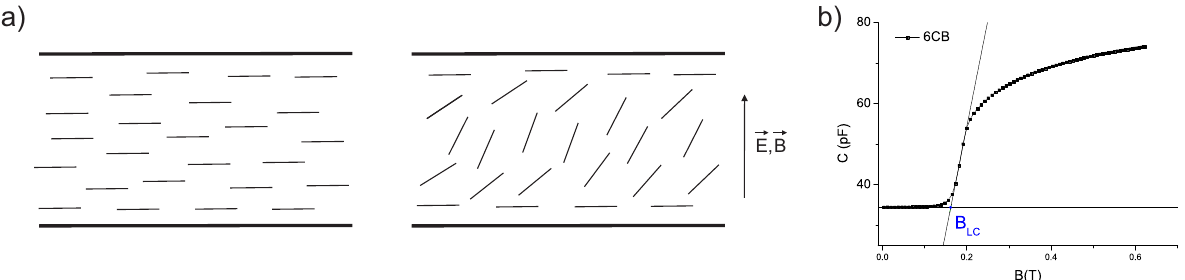
Figure 2. ( a ) Schematic geometry of Fréedericksz transition measurements in electric and magnetic field. ( b ) Demonstration of threshold value determination on pure 6CB liquid crystal.